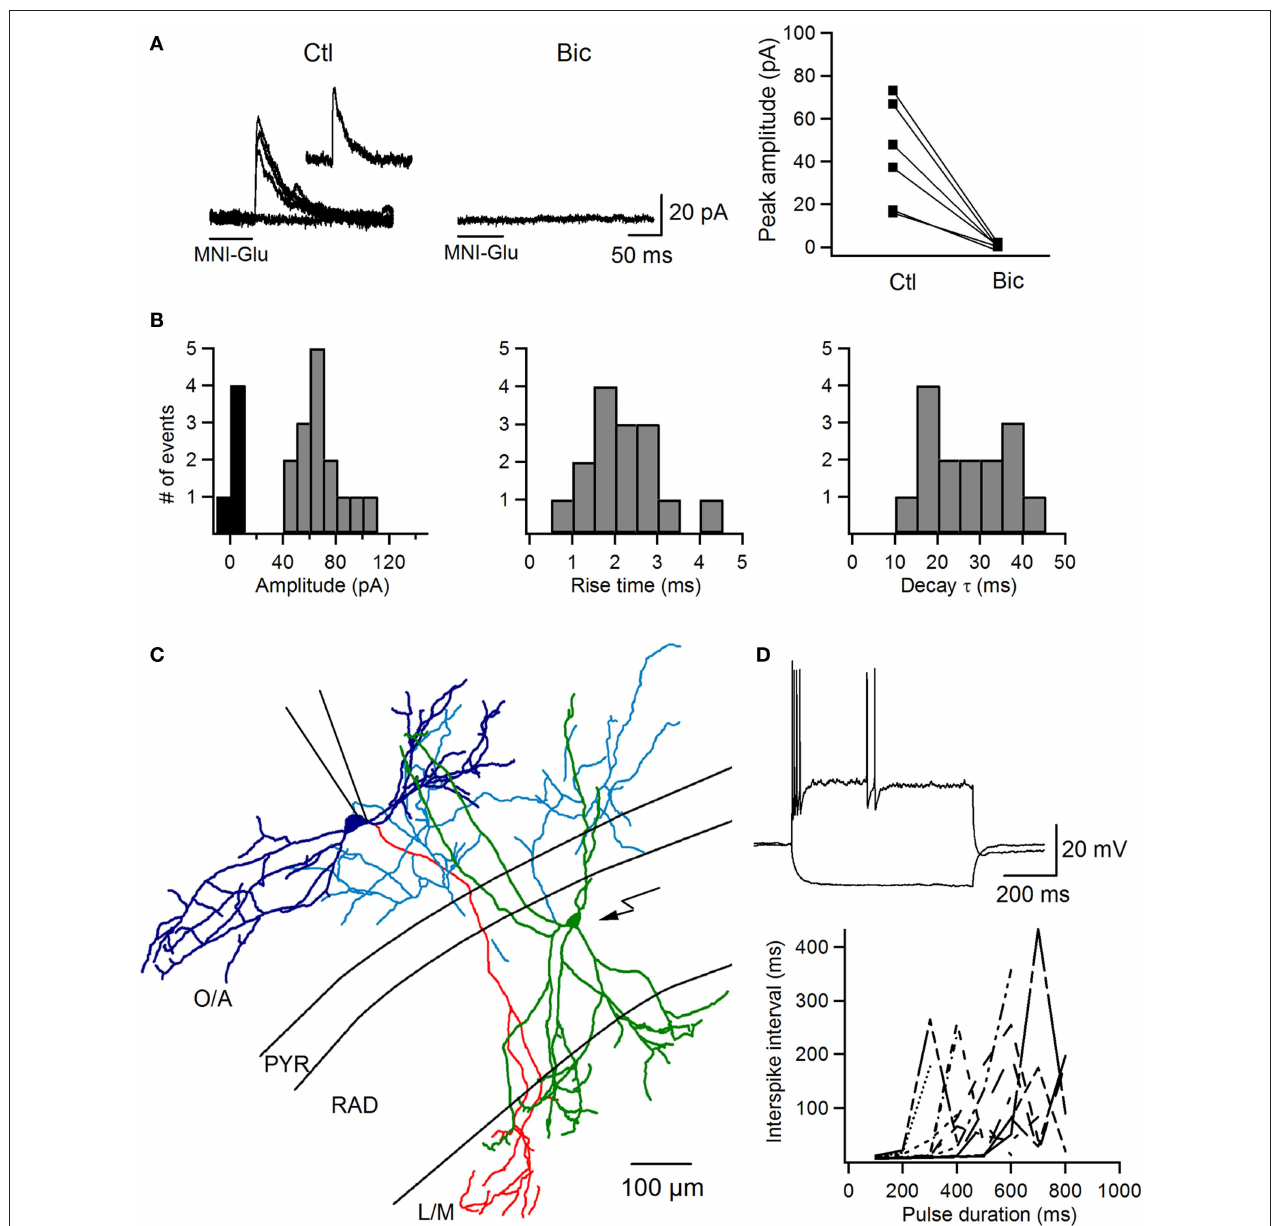
connected RAD and O–LM INs filled with biocytin, showing anatomical features (bipolar orientation, extensive axonal arborization in the O/A) of an interneuron innervating an O–LM cell. Soma and dendrites of the presynaptic RAD IN are shown in green, and its axonal arborization is shown in blue. Soma and dendrites of the postsynaptic O–LM IN are shown in dark blue and its axonal arborization is shown in red. (D) Responses of the presynaptic RAD IN to current pulses (top) and a plot of the interspike interval as a function of pulse duration at different levels of membrane depolarization (bottom) demonstrating the irregular firing pattern of the RAD IN innervating the O–LM